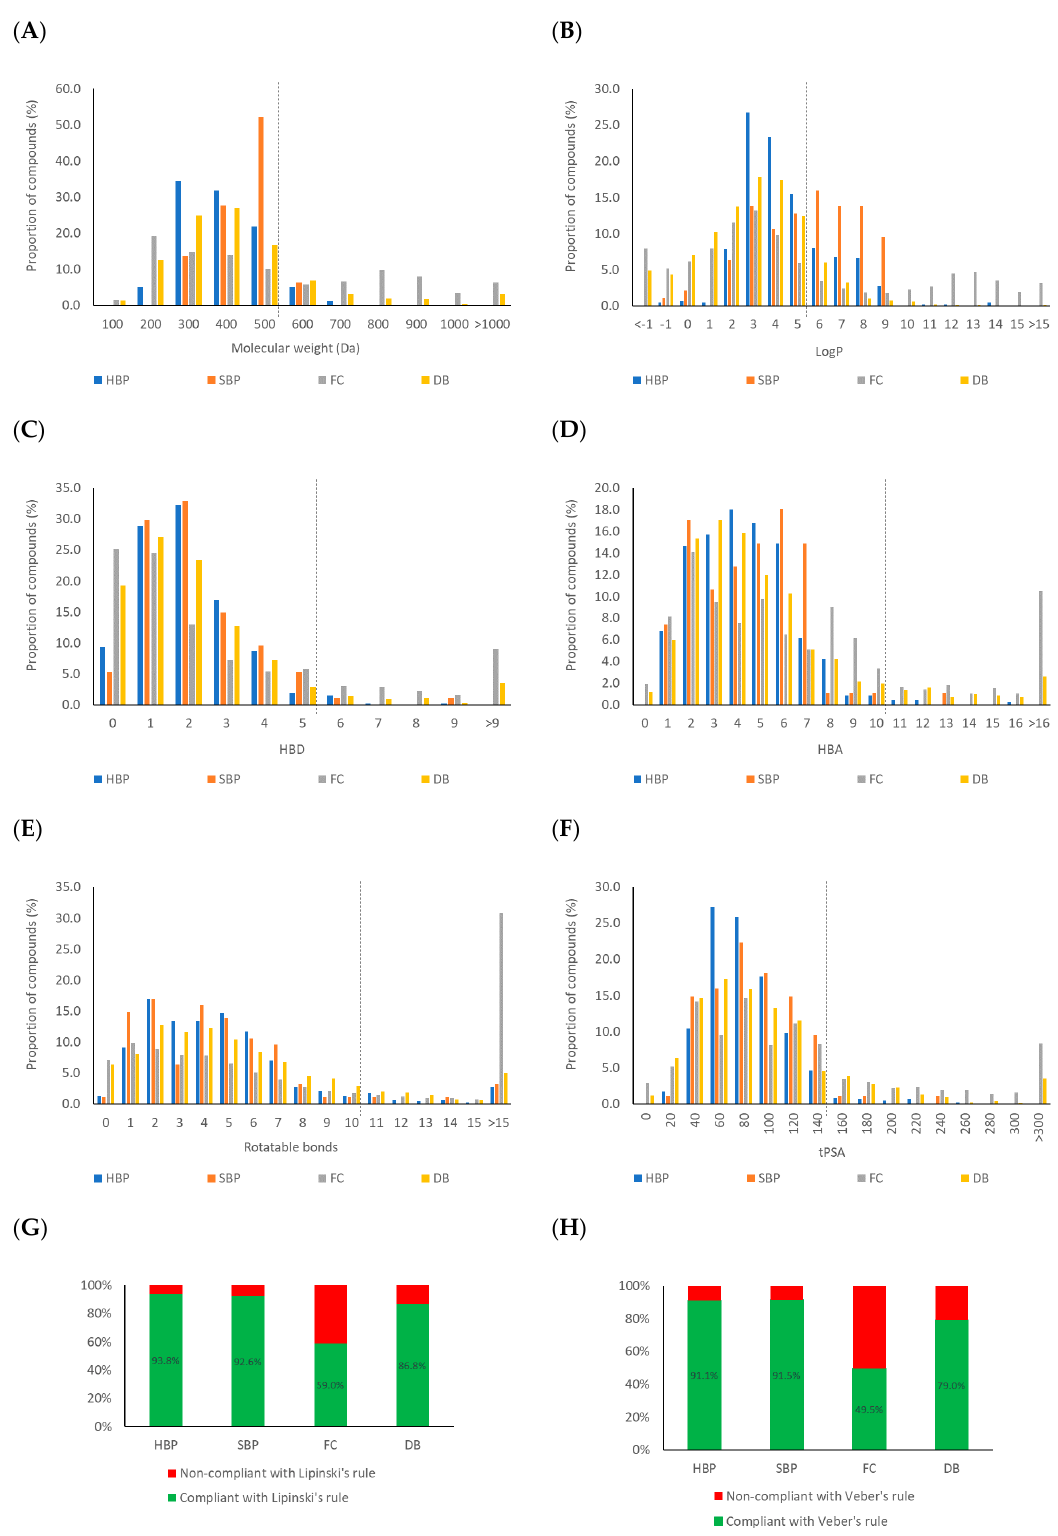
Figure 10. Comparisons of the physicochemical properties (Lipinski and Veber descriptors) of propolis components, food chemicals and approved drugs. ( A ) Molecular weight; ( B ) LogP; ( C ) hydrogen bond donors; ( D ) hydrogen bond acceptors; ( E ) rotatable bonds; ( F ) topological polar surface area; ( G ) Lipinski compliance; and ( H ) Veber